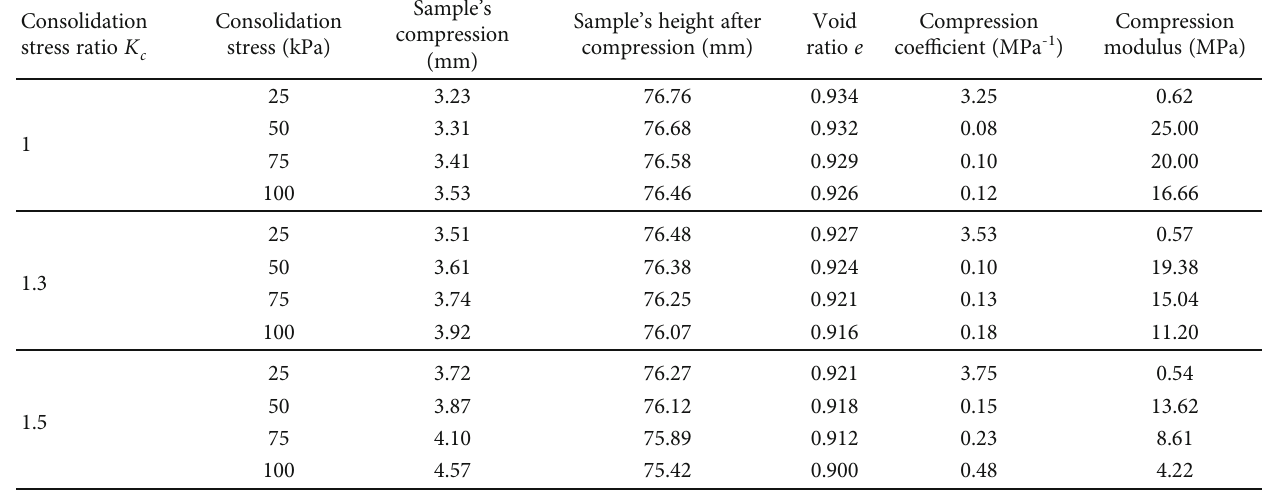
Table 8: Calculation results of deformation parameters of overconsolidation clay during consolidation.